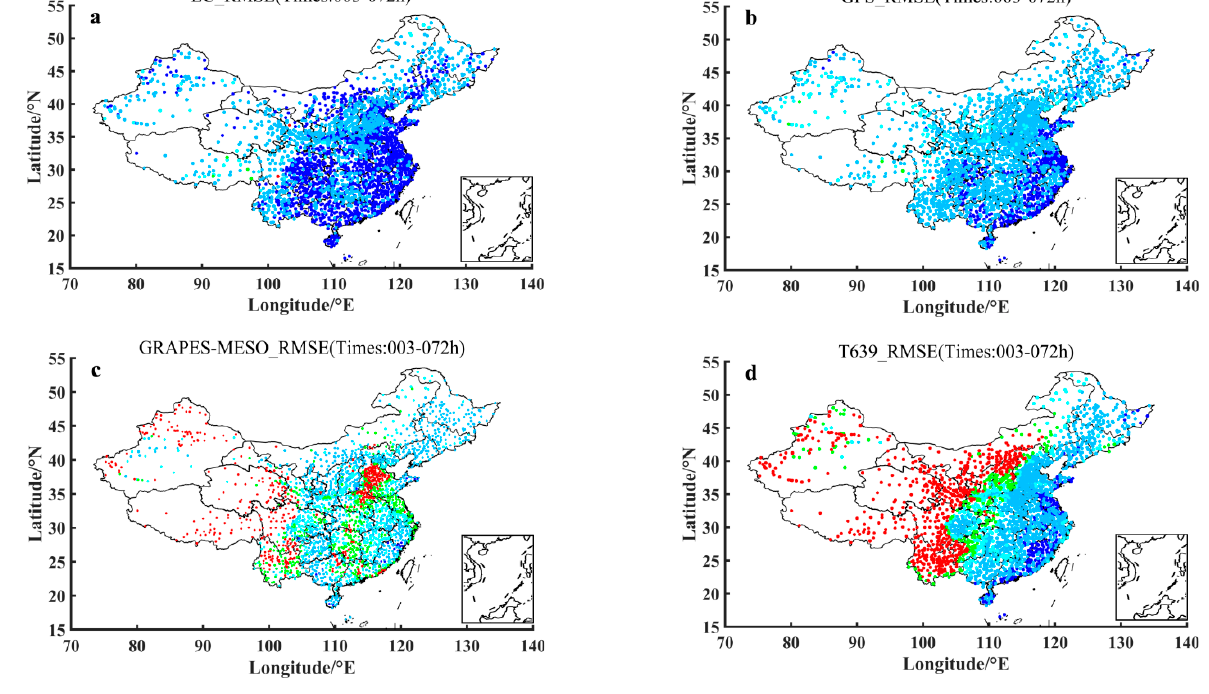
Figure 3. Spatial distribution of the averaged 2 m temperature prediction RMSEs (units: °C) of 2380 surface stations of China over October 2015 with respect to the averaged prediction leading times over the period within 72 h for ECMWF ( a ), GFS ( b ), GRAPES-MESO ( c ) and T639 ( d ) models.